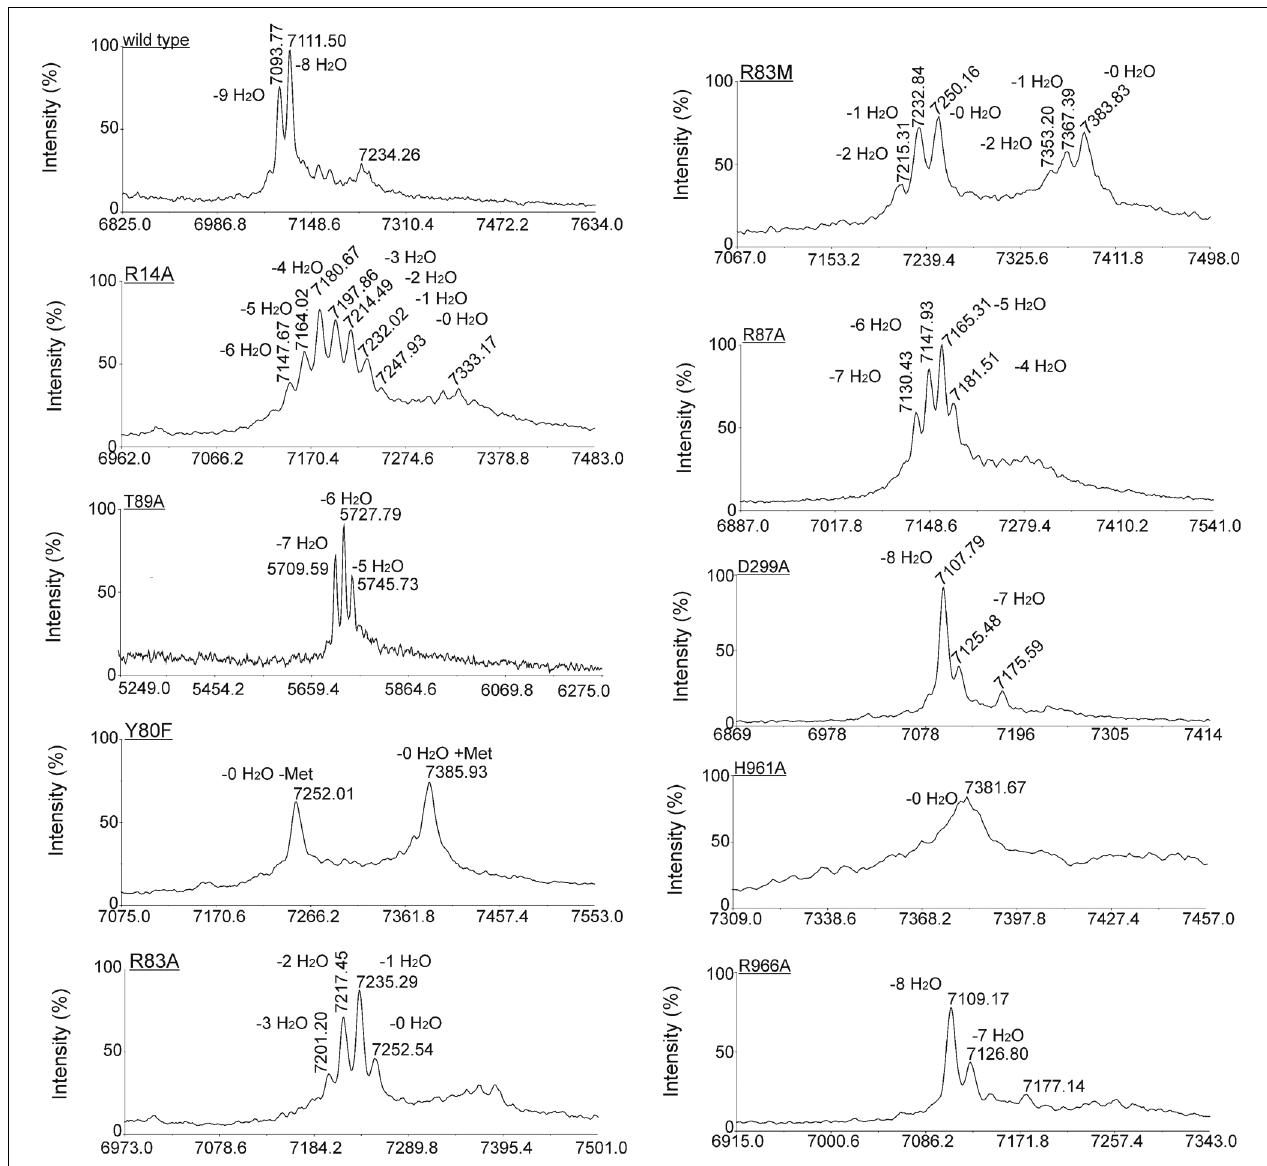
FIGURE 3 | Effect of NisB mutagenesis on the extent and pattern of dehydration of precursor nisin. Matrix-assisted laser desorption ionization–time-of-flight (MALDI-TOF MS) spectra were obtained of Ni-NTA purified precursor nisin mutants containing the C-terminal extension GSIEGR followed by His6 tag, and modified by NisB mutants in vivo. In the case of mutants of NisB that resulted in a lack of secretion ( Table 1 ), the His-tagged